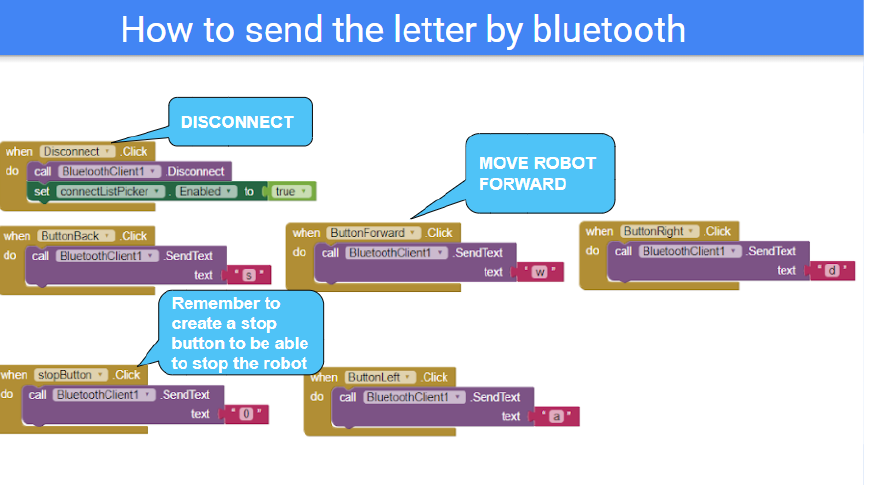
Figure 15. Example of blocks programmed by a high-school student to move the robot platform via Bluetooth).